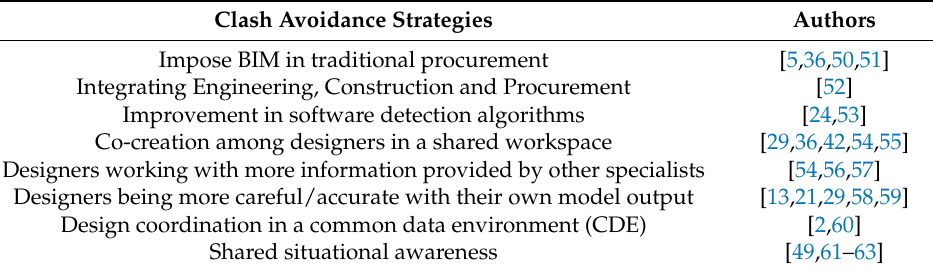
Table 2. Summary of clash avoidance strategies by